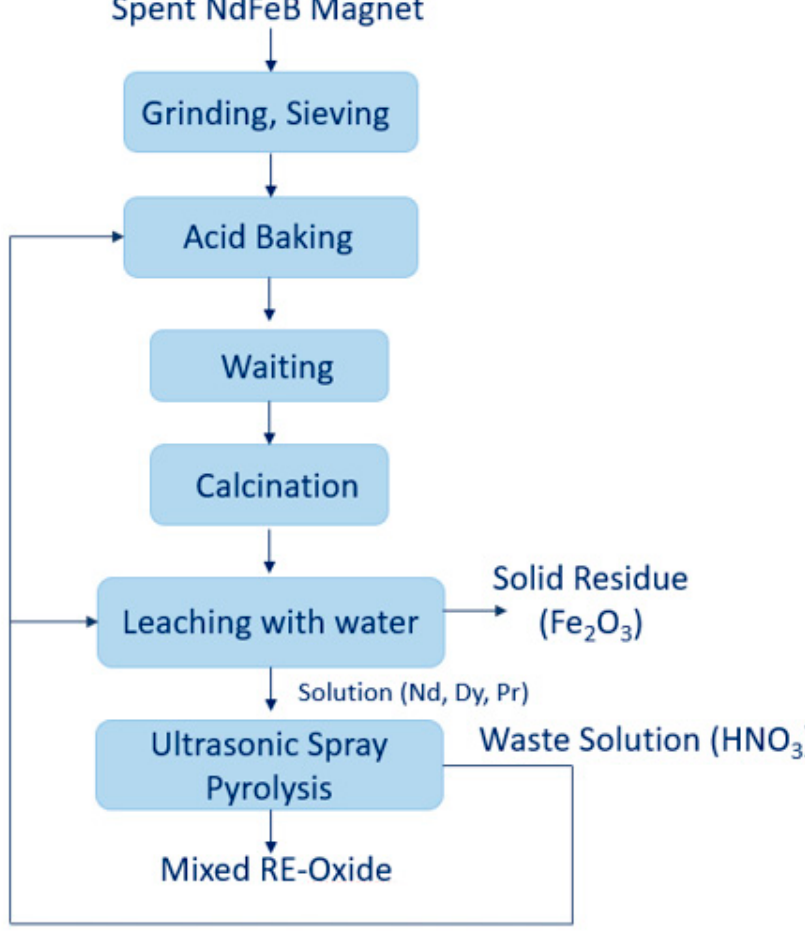
Figure 10. Combined process for treatment of spent